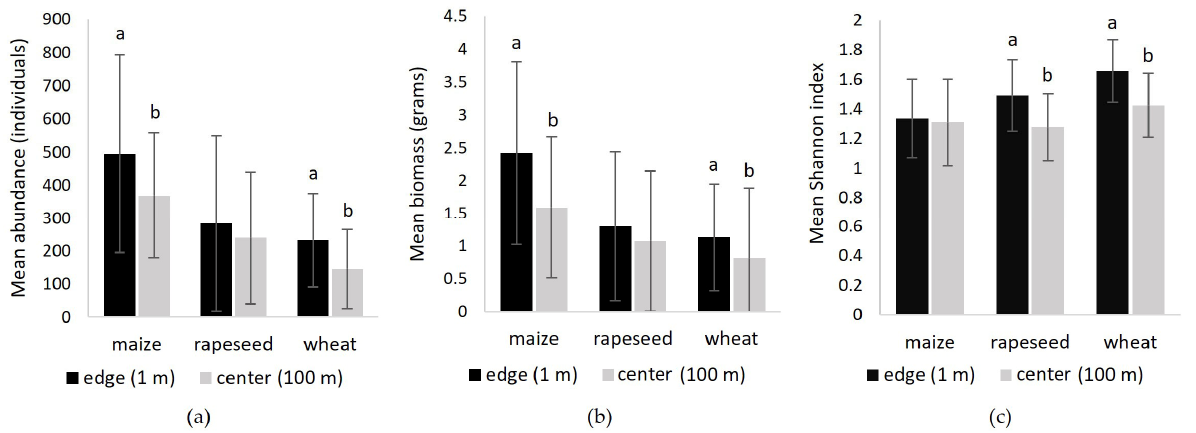
Figure 7. Comparison of ( a ) the mean abundance, ( b ) biomass and ( c ) Shannon index of individual crop types at different distances from the field edge. Vertical lines represent the standard deviation (SD). Superscripts indicate significant differences between edge and center for crop type, based on Tukey’s post ‐ hoc tests.